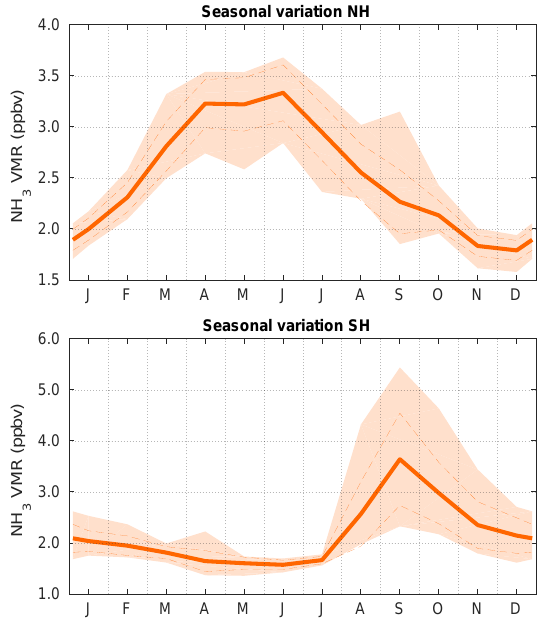
Figure 9. The NH 3 monthly mean variations (solid line) in the NH (upper panel) and the SH (lower panel), respectively. The long-dash lines show the 1 σ standard deviation (SD); and the shaded areas represent the maximum and minimum range of each data